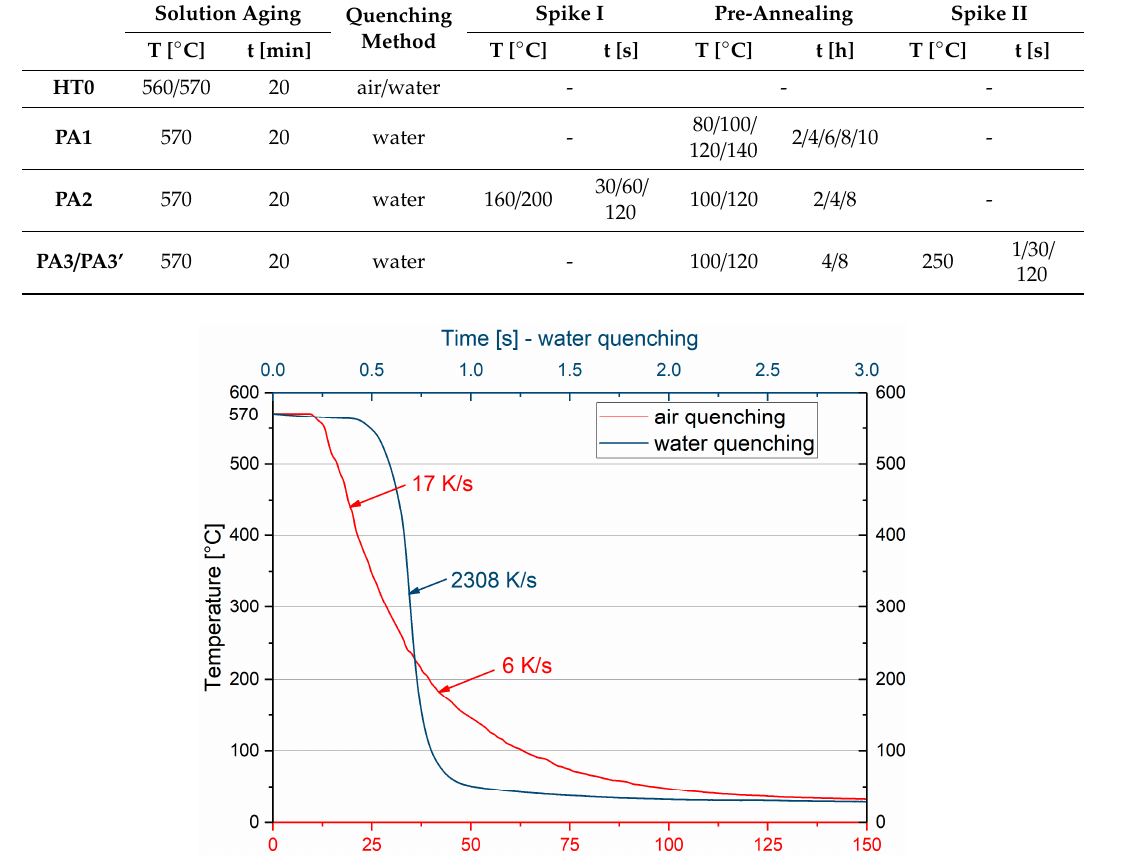
Table 2. Detailed overview of each heat treatment.